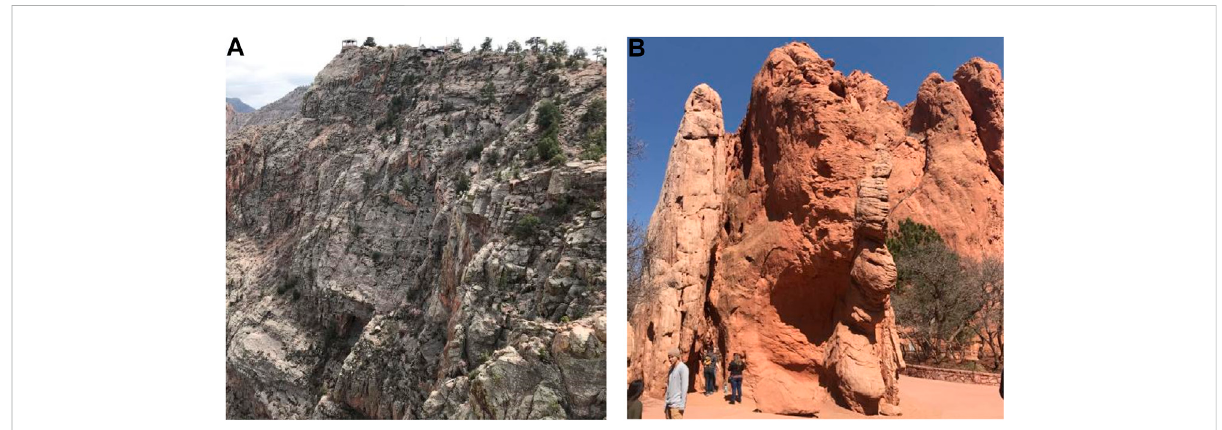
FIGURE 1 Examples of dangerous rock mass on rock cliffs. (A) Potential unstable rock mass. (B) Dangerous rock mass.